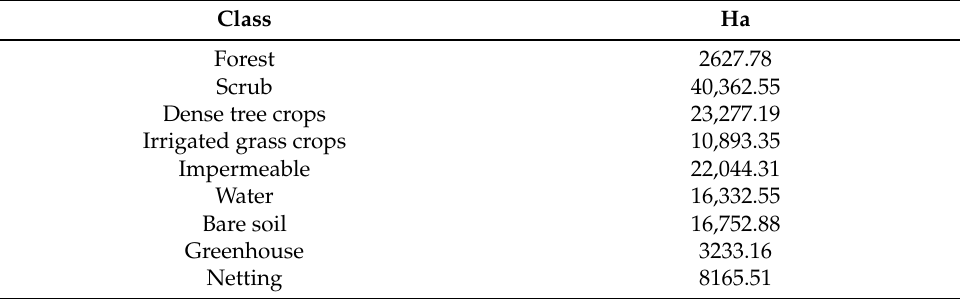
Table 9. Total surface classified for each